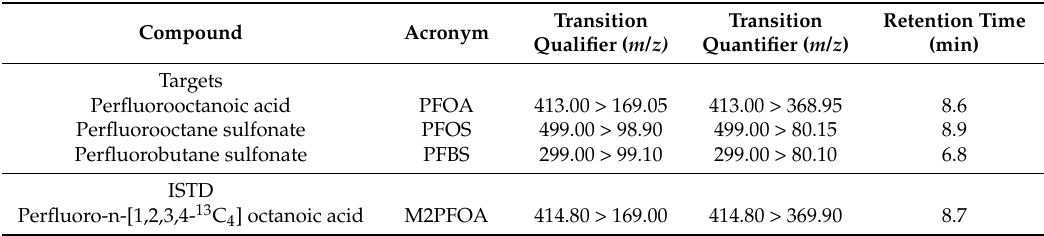
Table 1. Names and multiple reaction monitoring (MRM) transitions of three perfluoroalkyl substances (PFASs) and one internal standard (ISTD).